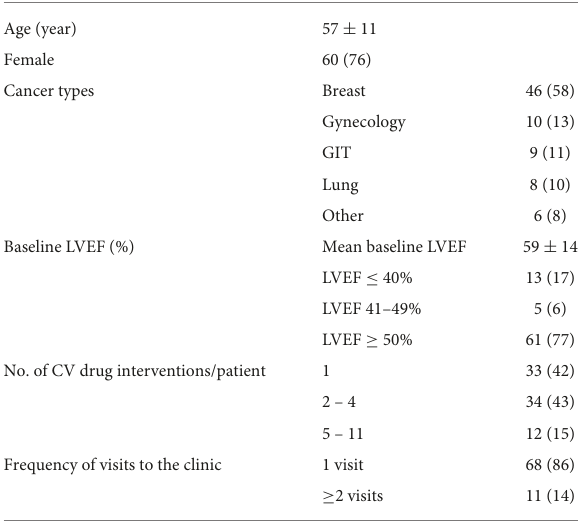
TABLE 1 Characteristics of patients with drug interventions at the first established cardio-oncology clinic in Iraq.